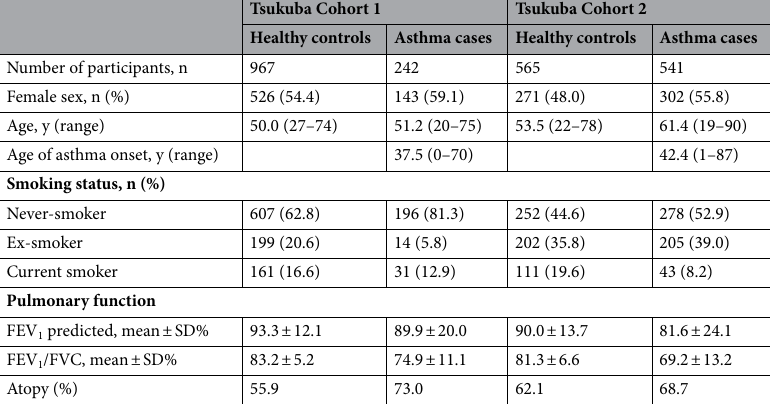
Table 1. Characteristics of the study cohorts. In asthma cases in Tsukuba cohort 1, information on smoking status, pulmonary function, and atopy was missing in 1, 5, and 27 individuals, respectively. In healthy controls in Tsukuba cohort 2, information on pulmonary function was missing in 5 individuals. In asthma cases in Tsukuba cohort 2, information on age of asthma onset, smoking status, pulmonary function, and atopy was missing in 39, 15, 43, and 91